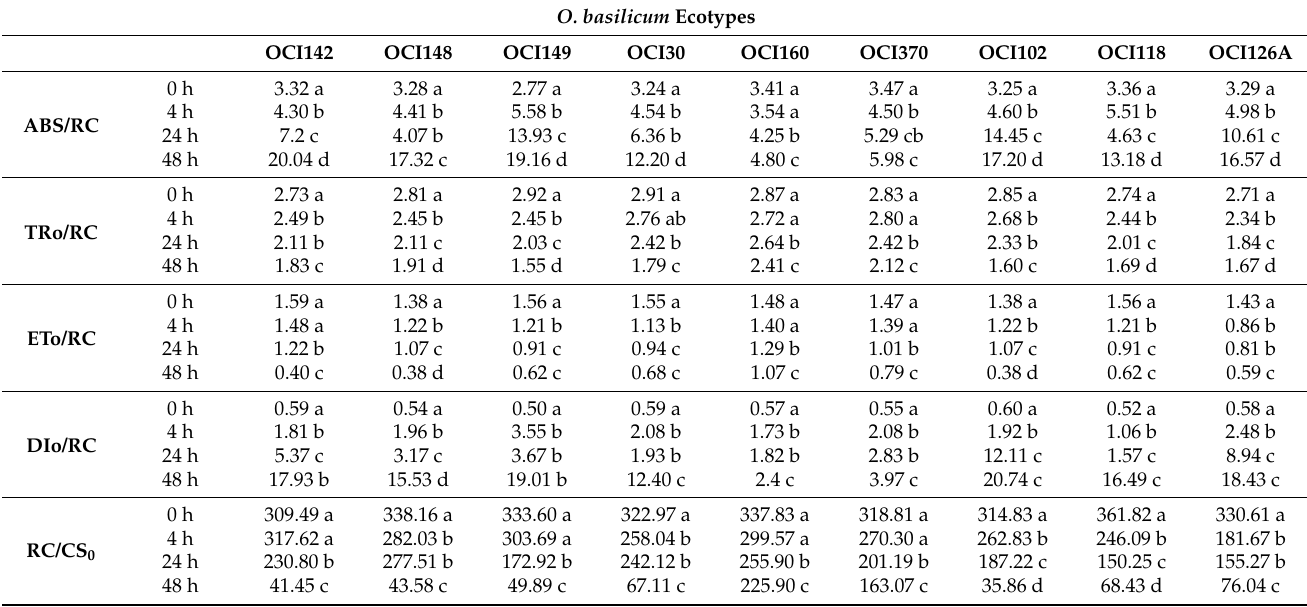
Table 2. Effect of UV-B exposure (68 kJ m − 2 day − 1 ) in nine different sweet basil ecotypes at different recovery times (0, 4 h, 24, and 48) on selected chlorophyll a fluorescence parameters. Analysis of variance was used for comparisons. Means within each column ( O. basilicum ecotypes) and within each chlorophyll a fluorescence parameter assessed followed by different letters are significantly different ( p < 0.05; Tukey’s multiple range test, n >